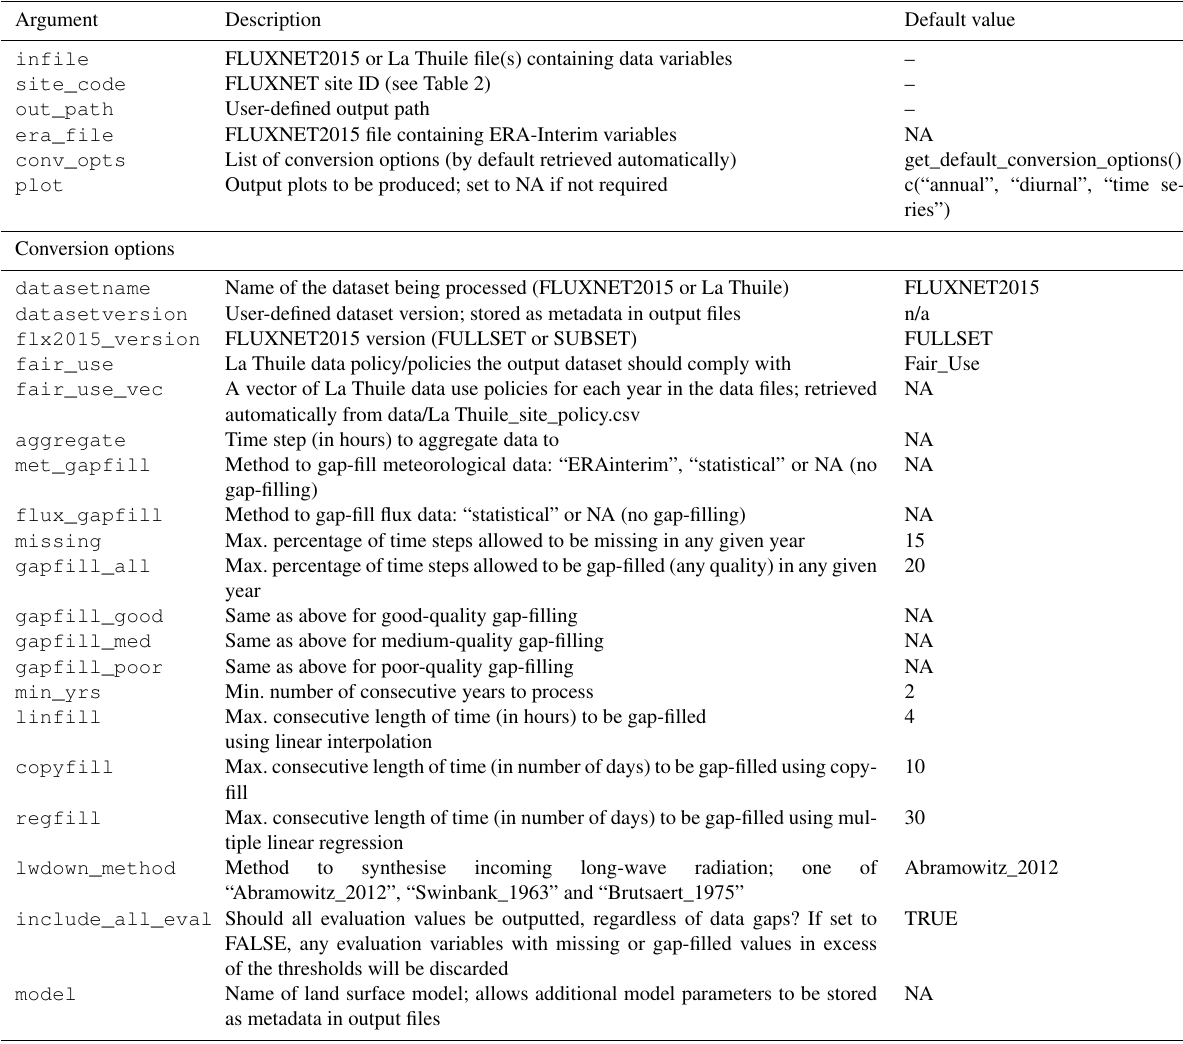
Table 1. Input arguments to the main convert_fluxnet_to_netcdf function. Conversion options can be passed directly into the function or retrieved using get_default_conversion_options() (see example in Sect. S1 in the